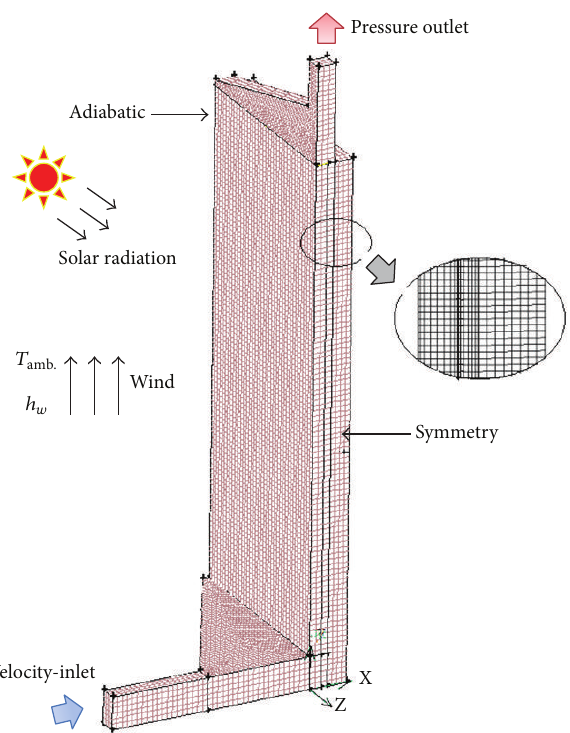
Figure 4: Computational model and boundary